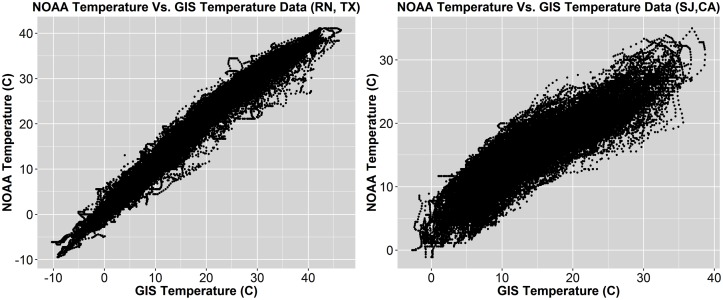
Comparison of NOAA and GIS temperature data (°C).Left: Richardson, TX (r = 0.995), Right: San Jose, CA (r = 0.887).